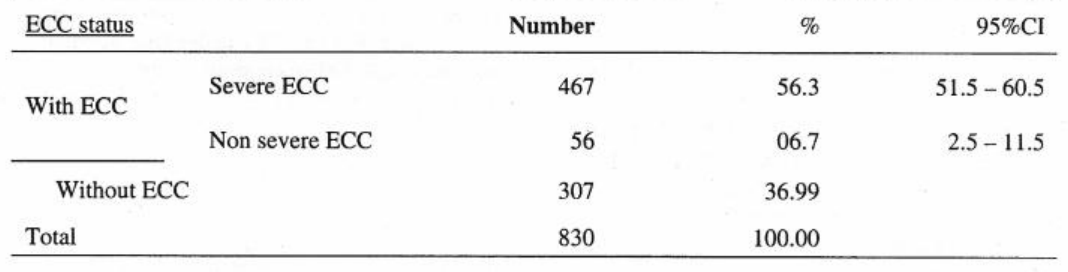
Table 4, Prevalence of ECC amongstudy populationclassified accordingto severity